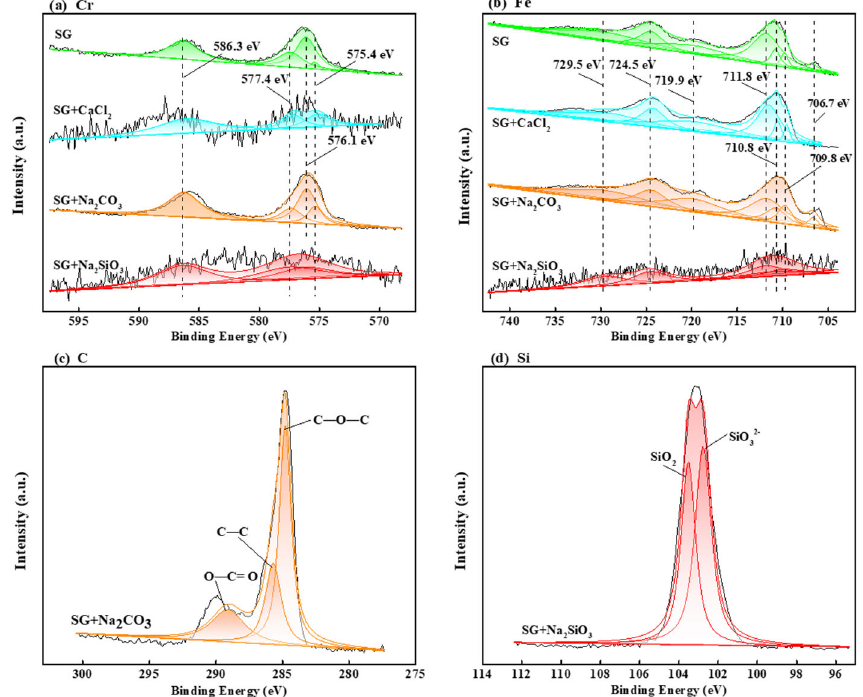
Figure 4. The EDS analysis of 304 stainless steel treated by polarization measurements in different solutions: ( a ) SG; ( b ) SG + CaCl 2 ; ( c ) SG + Na 2 CO 3 ; ( d ) SG + Na 2 SiO 3 .